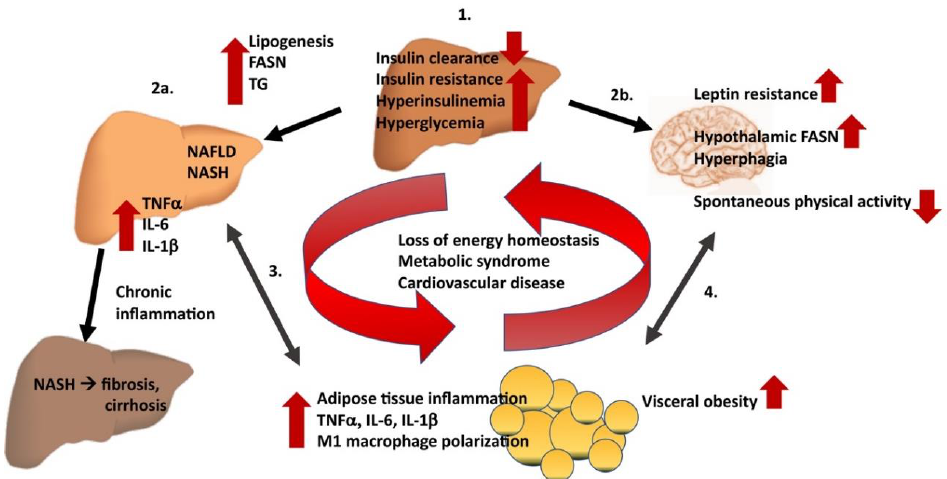
Figure 4. Pathophysiological consequences of loss of CEACAM1 expression and function. Hepatic inactivation or global loss of functional CEACAM1 expression impairs insulin clearance to cause insulin resistance and fatty liver disease in addition to disturbed energy homeostasis.